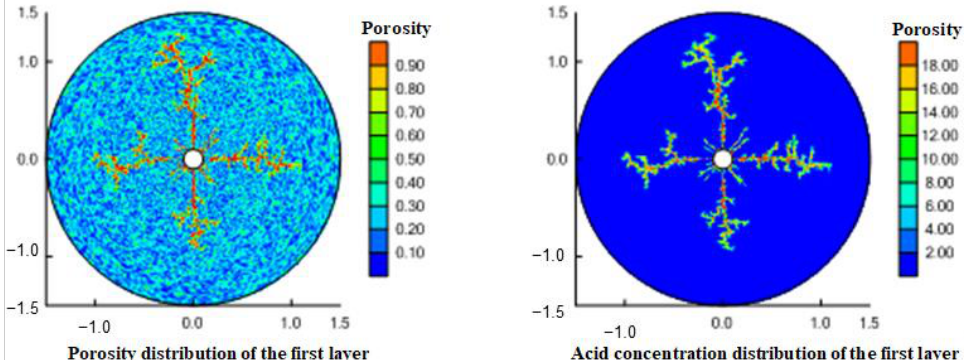
Figure 14. Wormhole shape during 60° phase angle perforation.